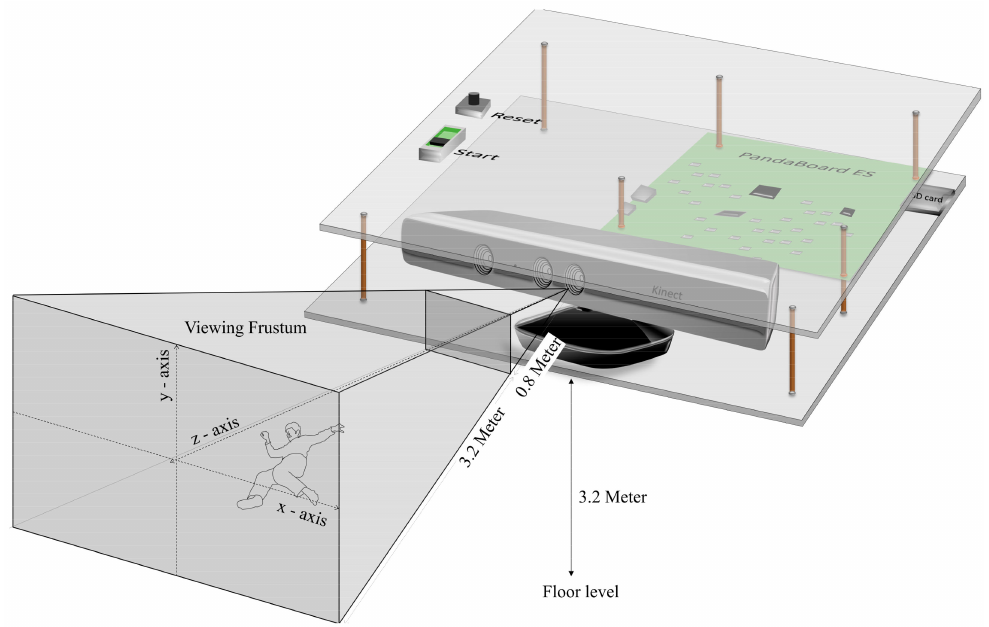
Figure 8. Prototype of the developed